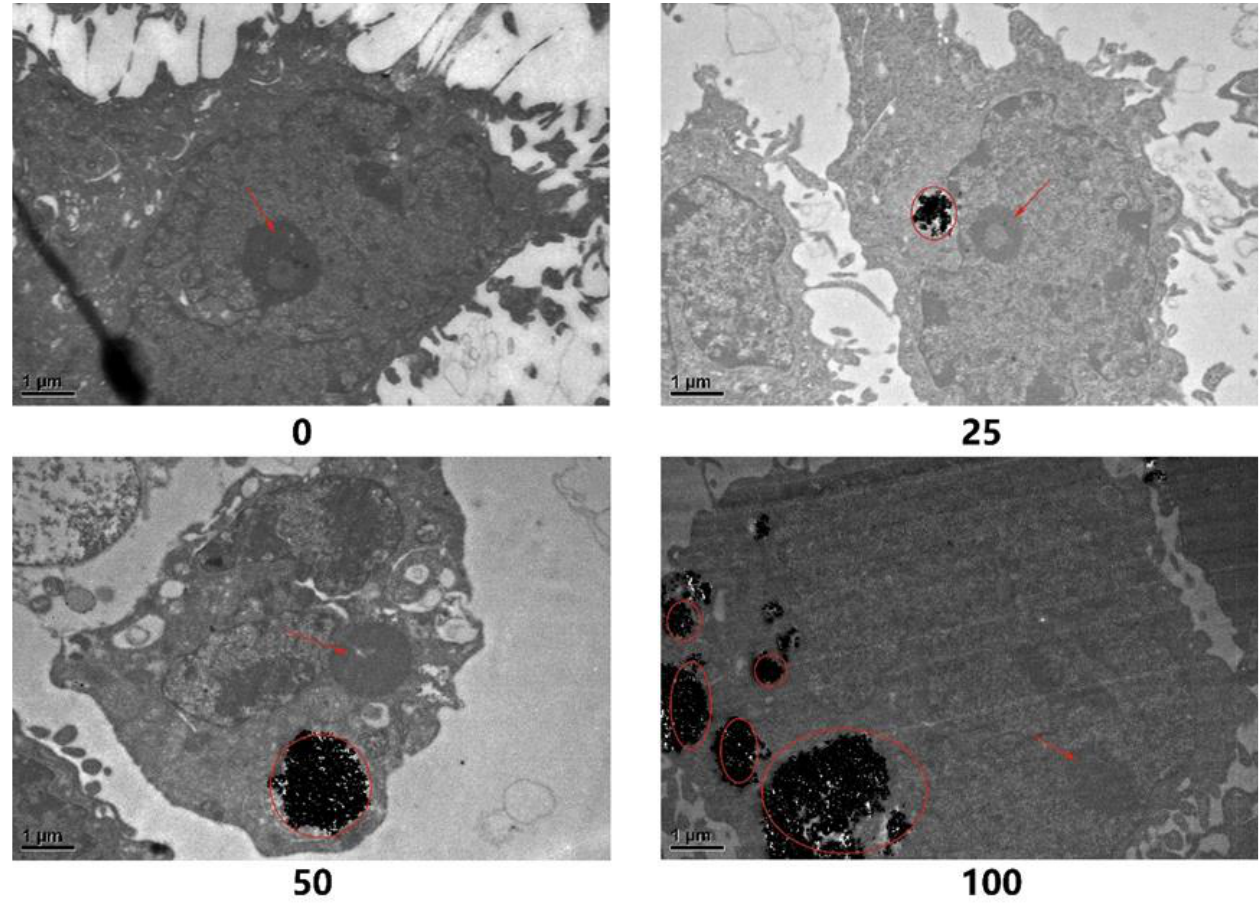
Figure 3 . TEM observation of the cellular uptake of TiO 2 NPs in BEAS-2B cells after exposure for 48 h. The magnification was 15,000×. The nanoparticles were circled by red ovals and the red arrows indicated the nucleoli of the nucleus. The numbers marked below the pictures are the exposure doses in µg/mL.